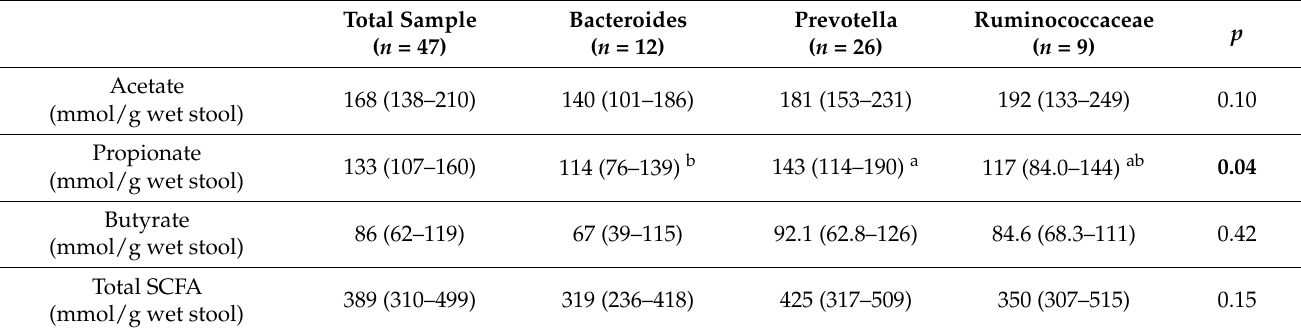
Table 3. Concentration of fecal short-chain fatty acids in